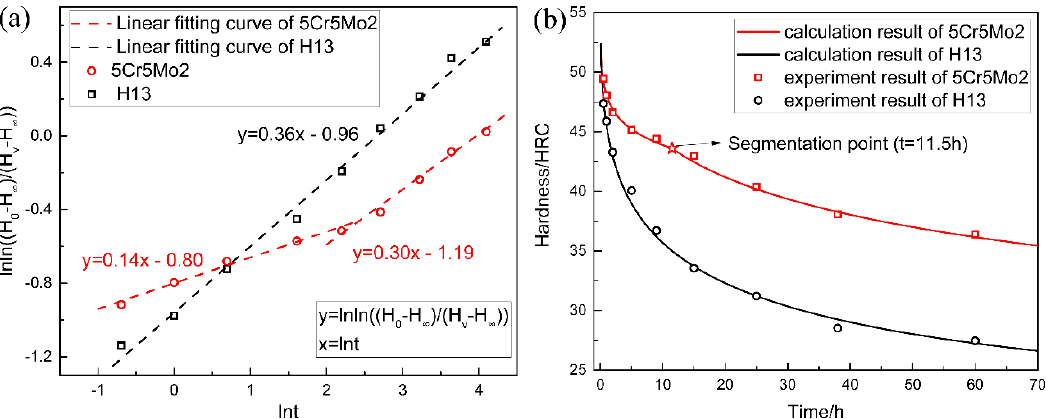
Figure 12. ( a ) Determination of the Avrami exponent n and ln D using curve fitting. ( b ) Softening Figure 12. (a) Determination of the Avrami exponent n and ln D using curve fitting. (b) Softening curves and experimental hardness results of the 5Cr5Mo2 and H13 steel curves and experimental hardness results of the 5Cr5Mo2 and H13 steel alloys.